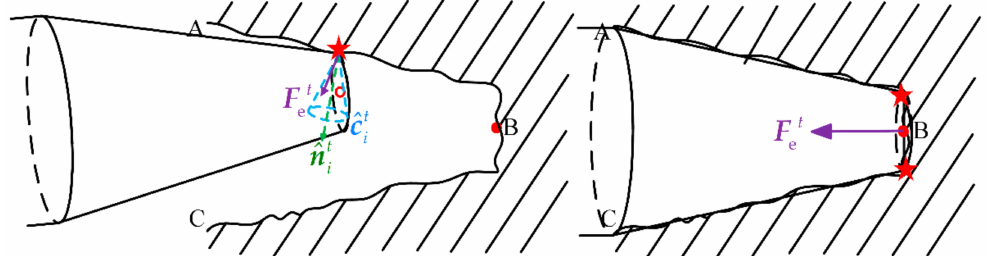
Figure 7. The force of the robot generated in different task progress